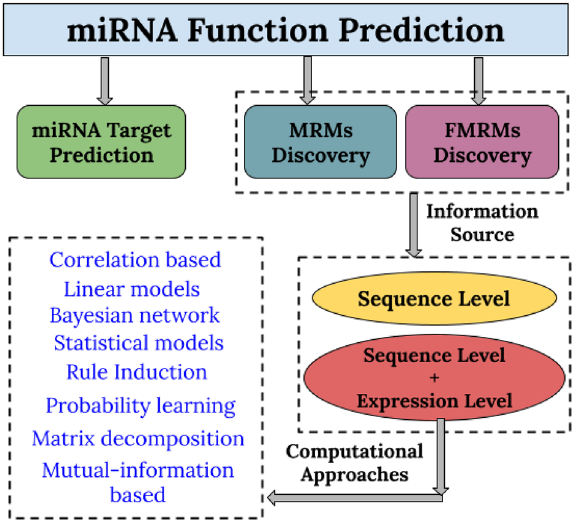
Figure 1: Workflow of the